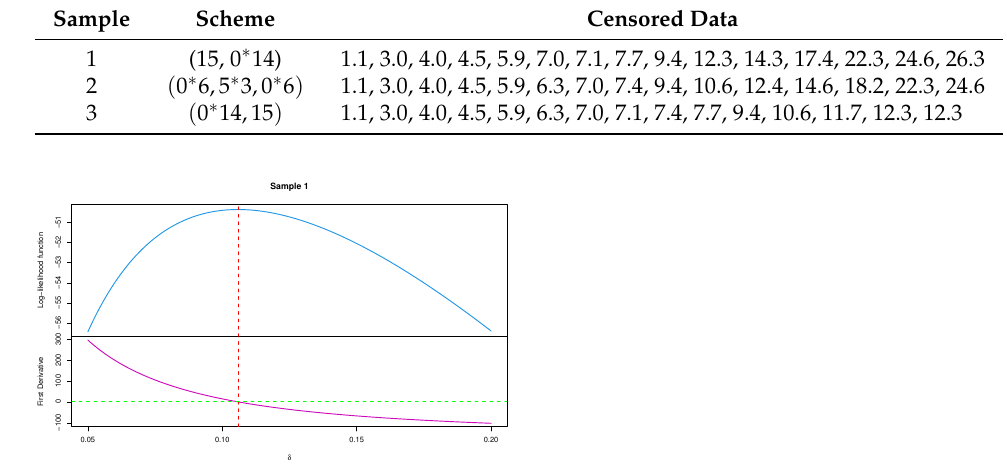
Figure 6. The log-likelihood function and the associated first derivative of δ from mechanical equipment